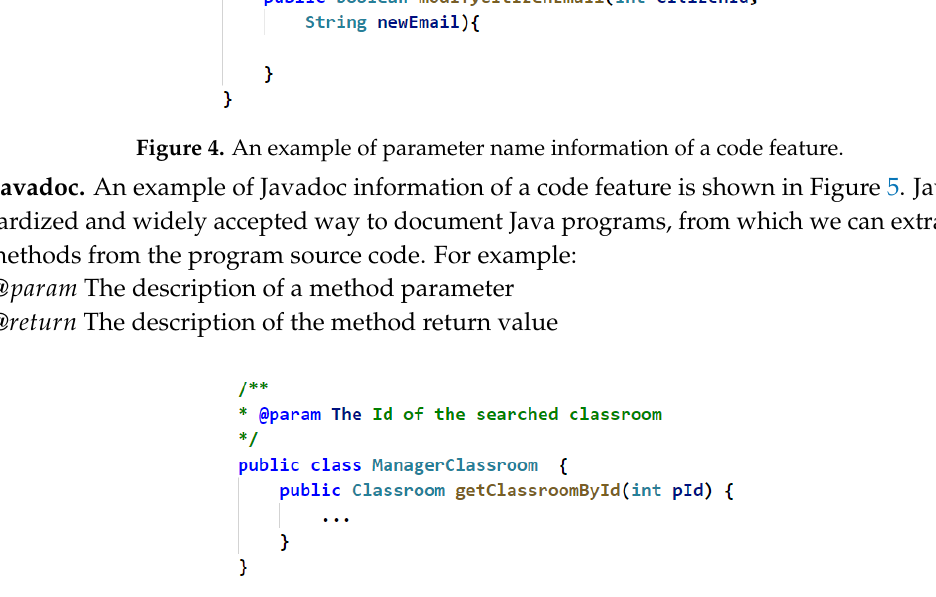
Figure 5. An example of parameter Javadoc information of a code